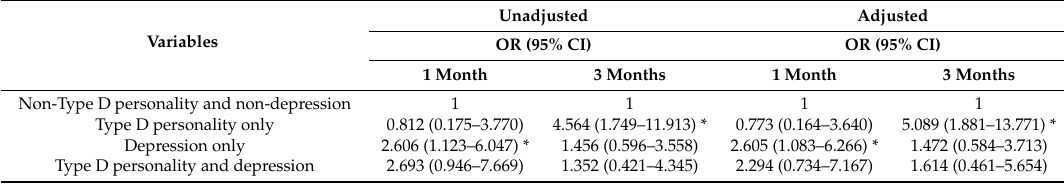
Table 4. Odds ratios (OR) for the association with medication non-adherence by Type D personality and depression at